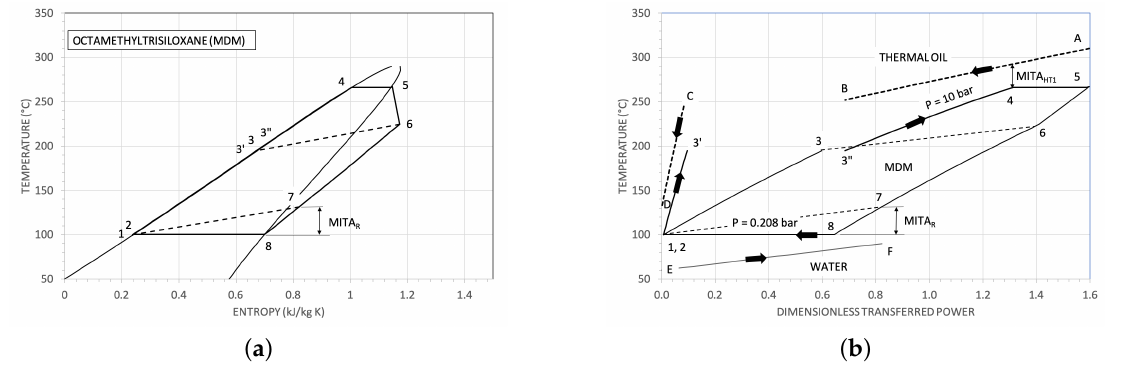
Figure 3. ( a ) Reference thermodynamic cycle with MDM as working fluid in a T − S plane. ( b ) The heat sources (thermal oil in HT 1 and in HT 2 loops and the cooling water) and the thermodynamic cycle in a temperature—dimensionless power plane.